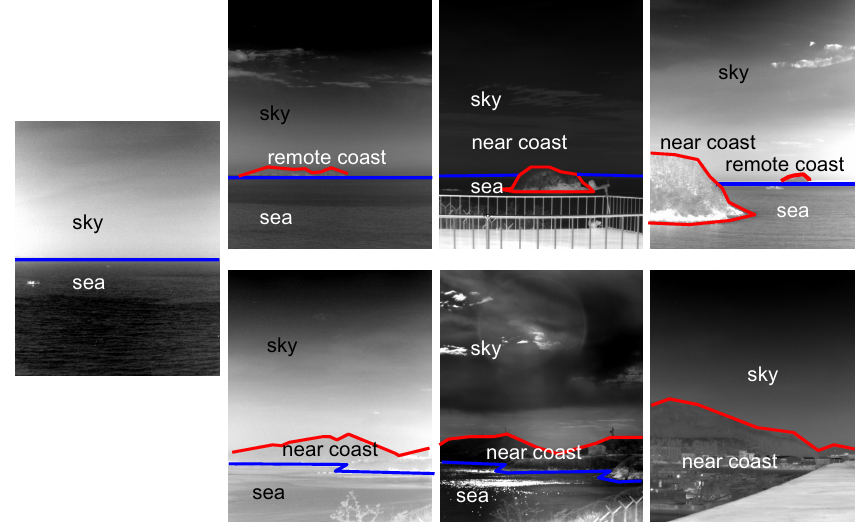
Figure 4. Proposed infrared scene interpretation system.